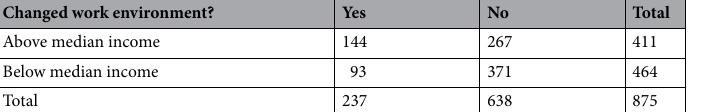
Table 1. CARE survey results for income and working from home due to COVID-19 (Victoria). From the CARE survey: comparison between above and below-median income groups’ responses to the question: ‘Have you personally experienced a change in work environment (working from home) because of COVID-19 and the measures to prevent its spread? (yes or